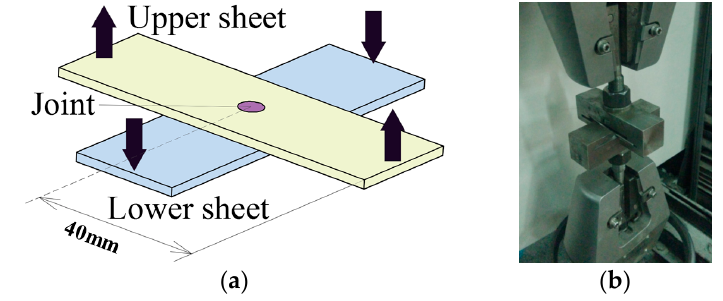
Figure 6. Specimen used for tensile test: ( a ) Specimen; ( b ) tensile testing fixtures.